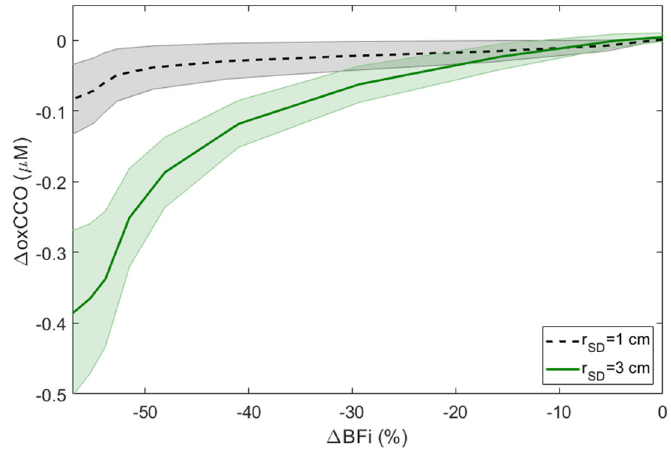
Figure 5. Relationship between reductions in BFi and corresponding changes in oxCCO. Results were averaged across subjects, and shading surrounding each line represents the standard deviation.